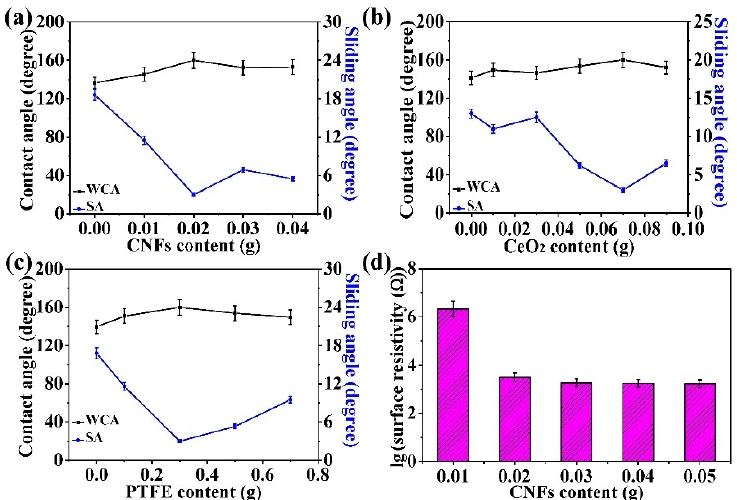
Figure 2. Line charts of the contact angle and sliding angle of the CSC coating at different ( a ) CNFs, ( b ) CeO 2 , and ( c ) PTFE contents. ( d ) Variations in the surface resistivity with CNF content. Accordingly, an appropriate surface roughness is indispensable for the preparation of superhydrophobic coatings. It was found that the technological parameters for obtain- ing optimal superhydrophobicity (160° WCA, 3° SA) on the coating surface were 0.02 g CNFs, 0.07 g CeO 2 , and 0.3 g PTFE. As shown in Figure 2d, the surface resistivity of the coating decreased gradually with increasing CNF content due to the excellent conductiv- ity of the CNFs. Table S1 (Supplementary Materials) shows the surface resistivity and log- arithmic values of the superhydrophobic coating with different carbon contents (g and wt%). At 0.02 g CNFs (2.22%), the surface resistivity decreased sharply to 3.10 × 10 3 Ω , and the variation of surface resistivity tended to be stable with the increase in CNF content. This phenomenon can be explained by percolation theory. As the CNF content increases, the continuous conductive paths gradually form in the coating, leading to a continuous decline in the surface resistivity. As the CNF content exceeds 0.03 g, the coating percola- tion ratio is close to 100%, resulting in the growth rate of the percolation group no longer varying significantly with increasing CNF content. It is clear from the above analyses that the coating surface not only possesses excellent superhydrophobicity, but also fine con- ductivity at 0.02 g CNFs. Therefore, the optimal technological parameters of the CSC coat- ing can be determined to be 0.02 g CNFs, 0.07 g CeO 2 , 0.3 g PTFE, 0.4 g PPS, and 0.1 g PDMS. 3.2. Surface Morphology and Wettability The surface micromorphology of the optimized CSC coating is shown in Figure 3a, and the insets are the WCA (160°) and SA (3°). The coating surface consists of various cured additives and displays the interlaced rough microstructure, which is of vital im- portance to the superhydrophobicity of the CSC coating. Figure 3c shows the silver mirror effect due to the CSC coating surface superhydrophobicity. According to Cassie theory [35], the air in the concave convex micro-nano structure reduces the contact area between water droplets and solid surface, improving the surface hydrophobicity. The superhydro- phobicity of the coating mainly depends on the synergistic effect of surface energy and micro-nano structure. The corresponding element distribution on the CSC coating surface is displayed in Figure 3d, and it can be seen that elements of various additives are distrib- uted on the coating surface. According to our previous work [33], the EDS spectrum of the obtained CSC coating surface is shown in Figure 3e and it can be easily seen that the CSC coating is composed of C, O, F, Si, Ce, and S. Additionally, the peaks of the F, Si, Ce, and S were attributed to the presence of PTFE, PDMS, CeO 2 , and PPS in the MSC coating,